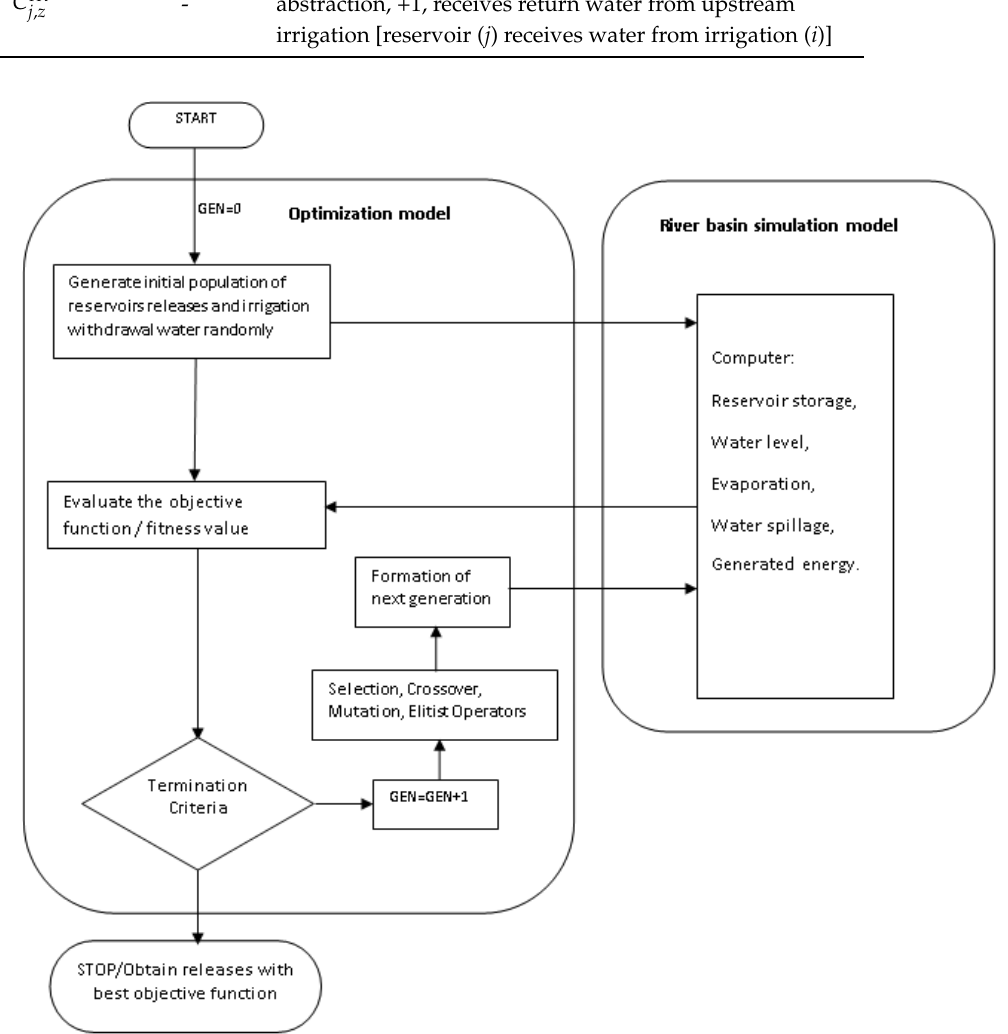
Figure 4. Conceptual framework of Eastern Nile Optimization Model (ENOM).